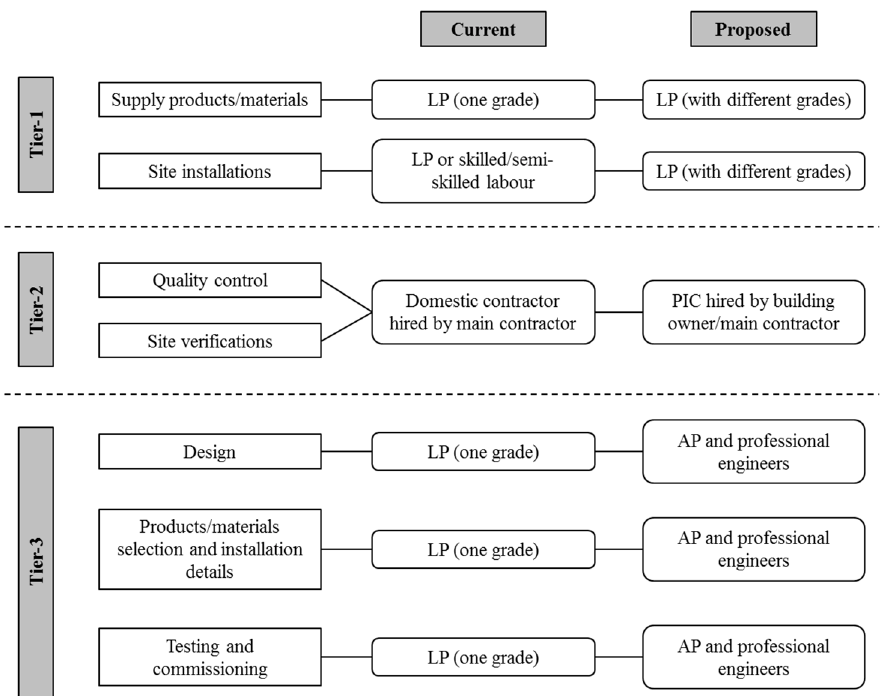
Figure 1. Proposed and current quality control system. Remarks: LP = licensed plumber; AP = authorized person; PIC = plumbing installation contractor.